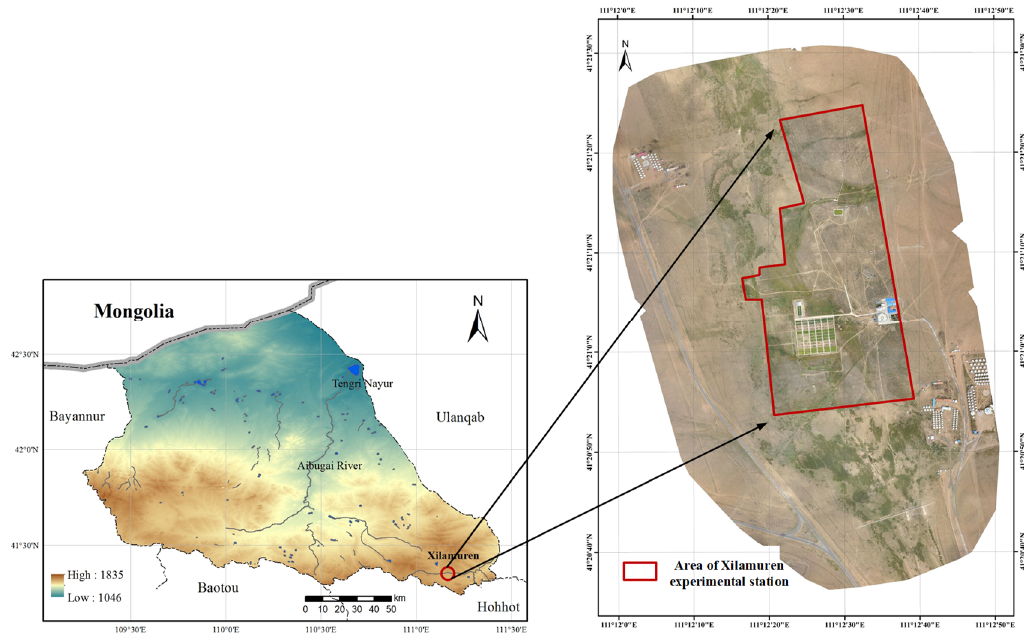
Figure 1. Geolocation and digital elevation of study site.